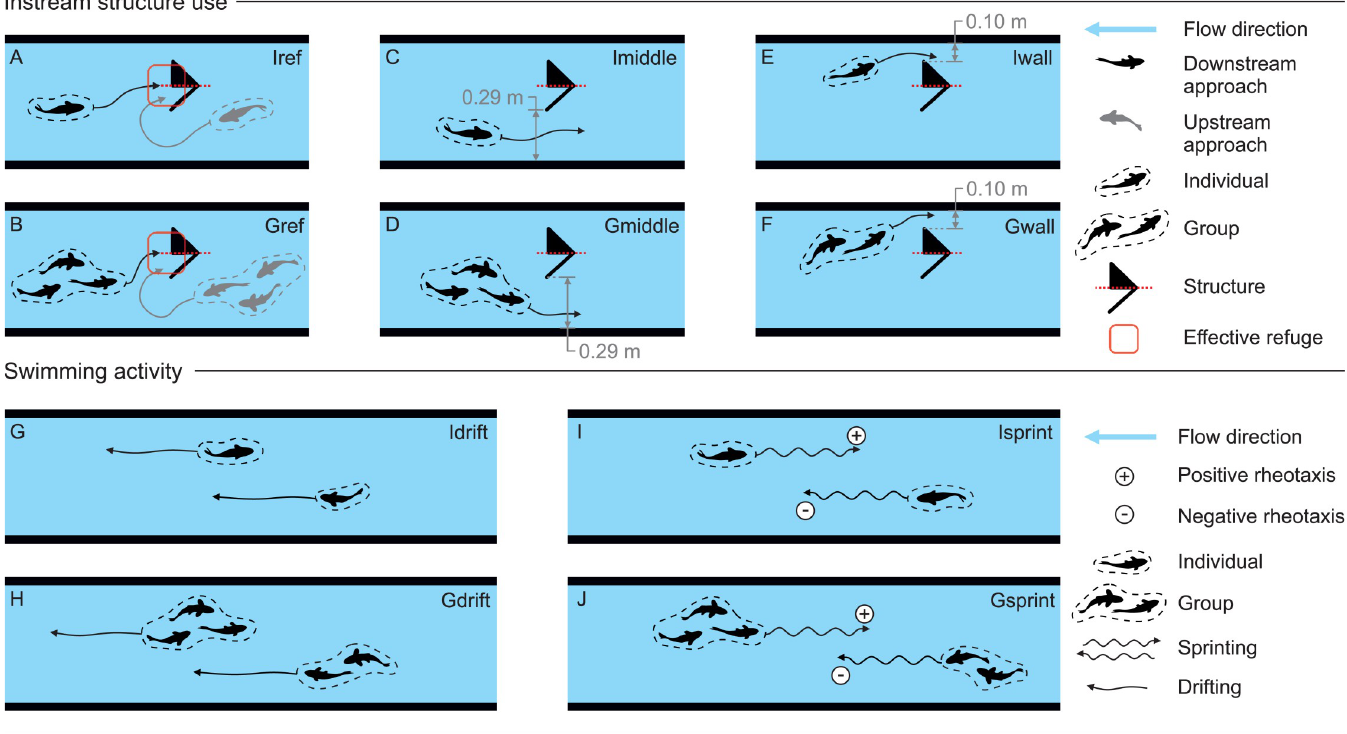
Fig 2. Classification of the behaviour metrics. (A and B)—Individual (Iref) and group (Gref) structure use; (C and D)–Individual (Imiddle) and group (Gmiddle) passage by the structures using longest distance between the structure and the flume wall; (E and F)–Individual (Iwall) and group (Gwall) passage by the structures using the shortest distance between the wall and the structure. (G and H) Individual (Idrift) and group (Gdrift) drifts. (I and J) Individual (Isprint) and group (Gsprint) sprints. Plus (+) and minus (-) signs represent the swimming direction of L . bocagei , as positive and negative rheotaxis respectively. These metrics were used for all